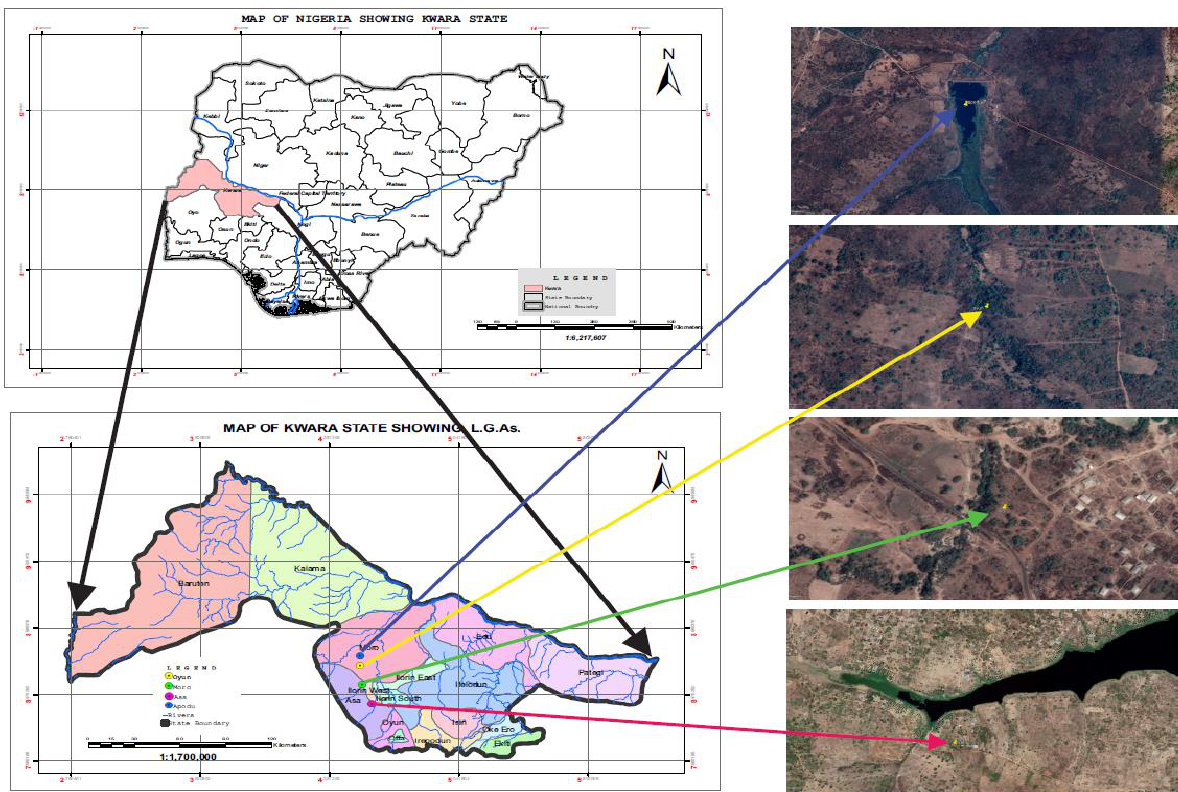
Figure 1 . Map of the sample collection sites surveyed in the different study areas